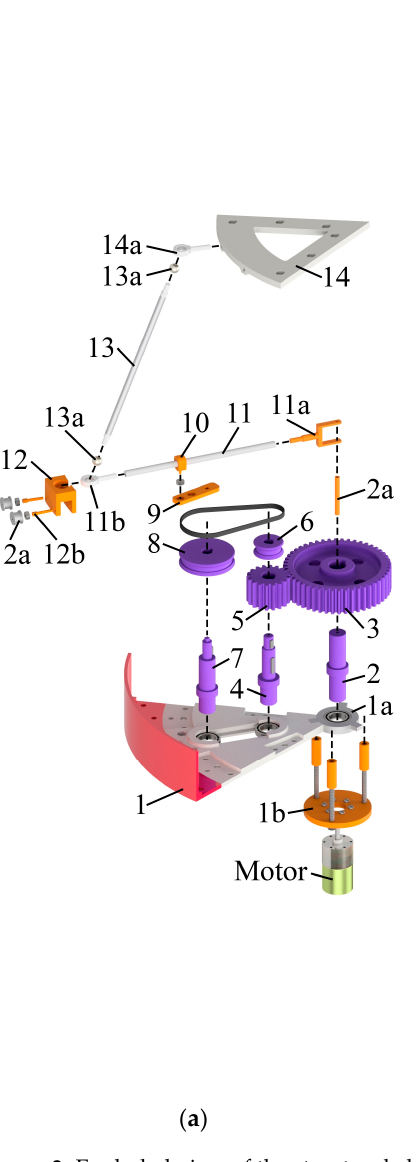
Figure 3. Exploded view of the structural elements assembly (CAD model) of the proposed hexapod: ( a ) single kinematic chain with a driving part; ( b ) complete mechanism model.